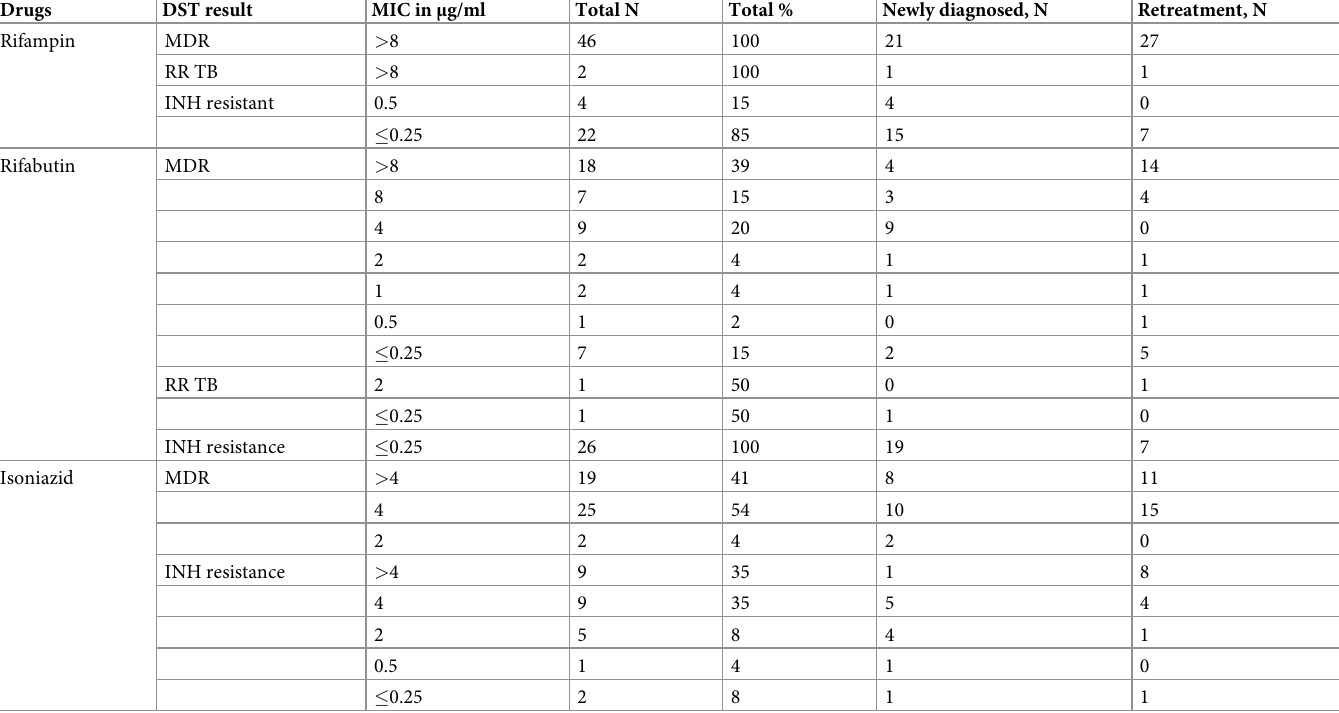
Table 1. Minimum inhibitory concentration of rifampin, rifabutin and isoniazid among multidrug resistant (MDR), rifampin resistant (RR) and isoniazid (INH) resistant Mycobacterium tuberculosis isolates.